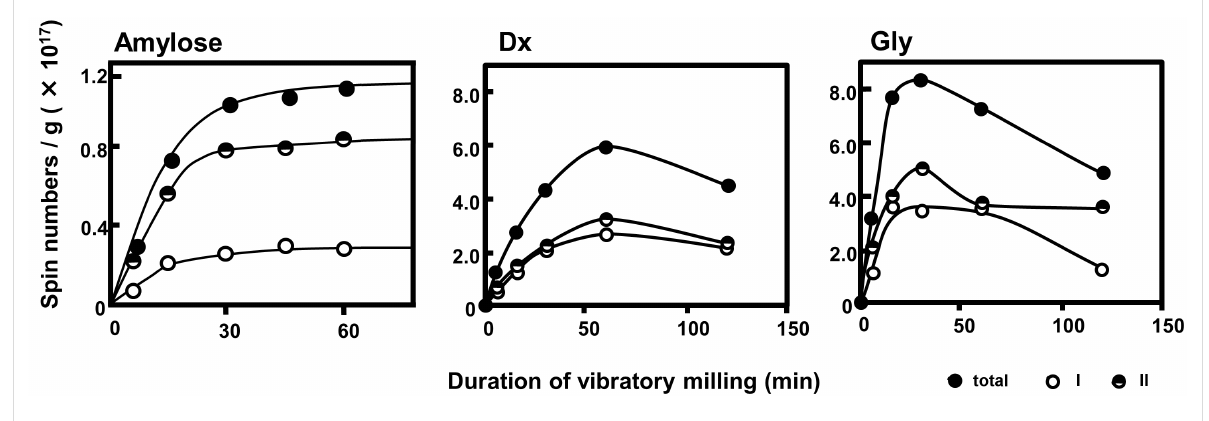
Figure 7: Progressive changes in the intensity of component spectra corresponding to the simulated spectra of amylose [5], Dx, and Gly.